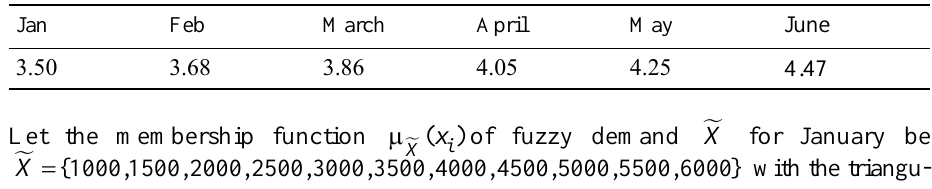
Table 1. Unit purchasing cost per month ($)